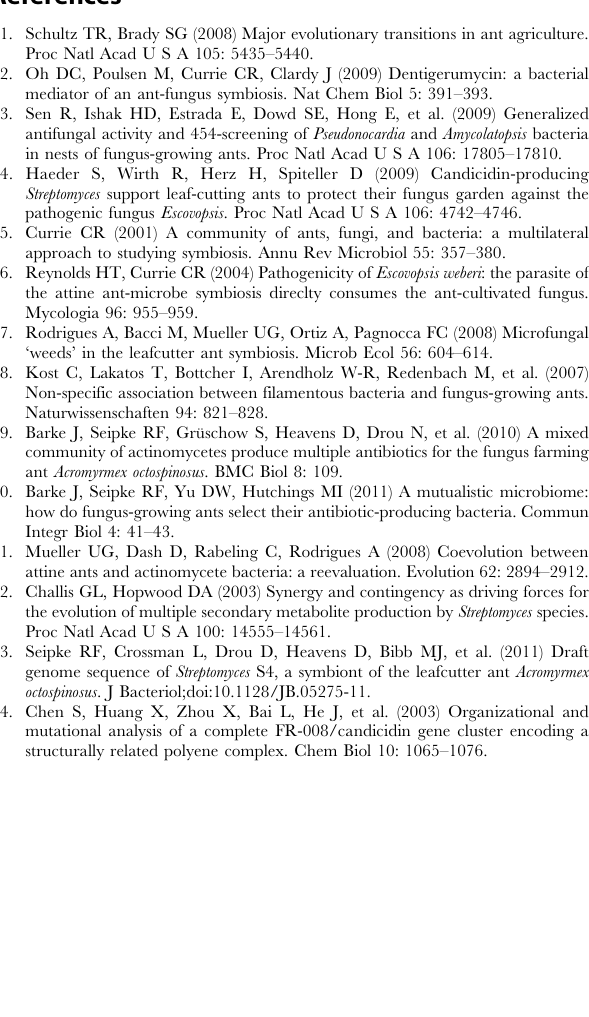
Table S1 Oligonucleotide primers used in this study.